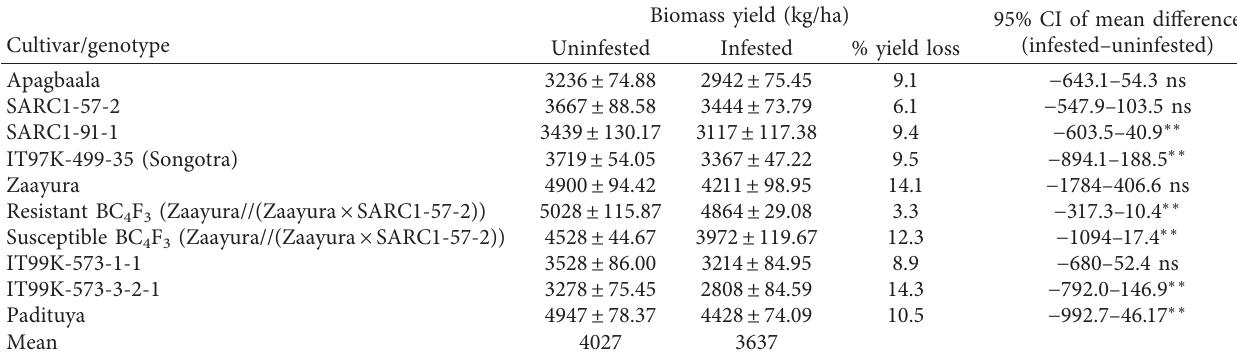
Biomass yield (kg/ha)